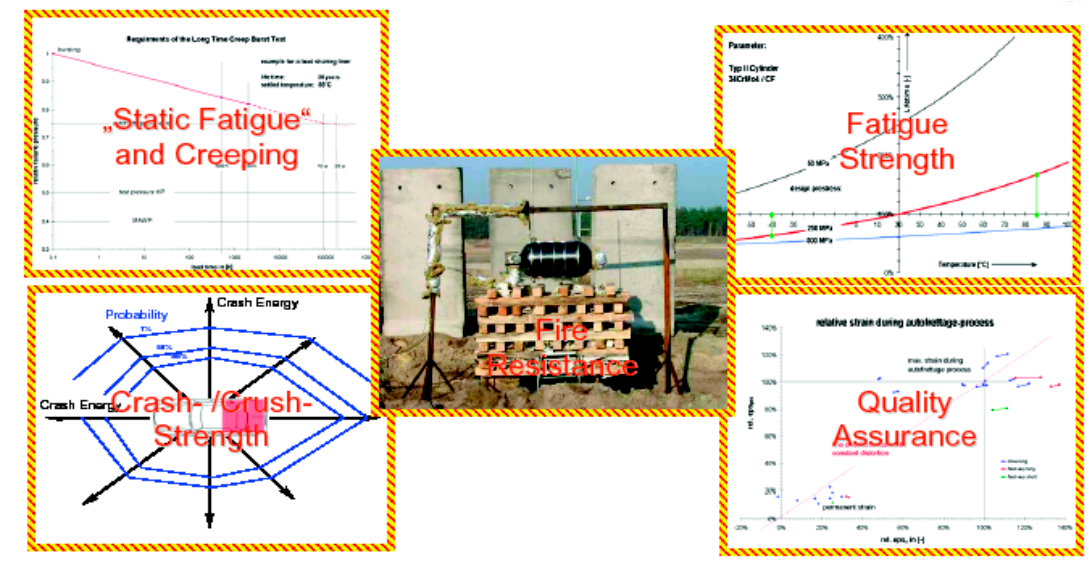
Figure 26. Carbon fiber composite structure of the inner tank and outer jacket [106].